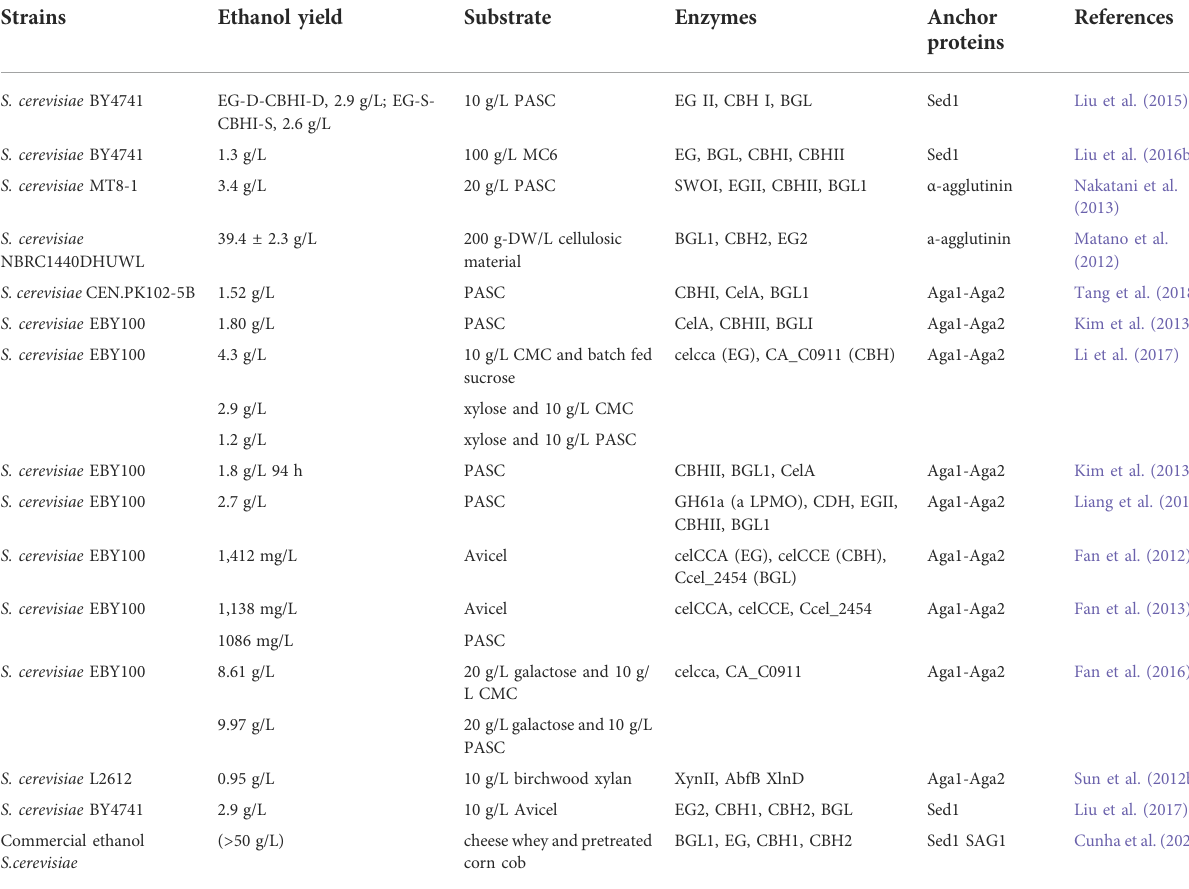
TABLE 3 Applications of S. cerevisiae cell surface display in cellulose degradation.